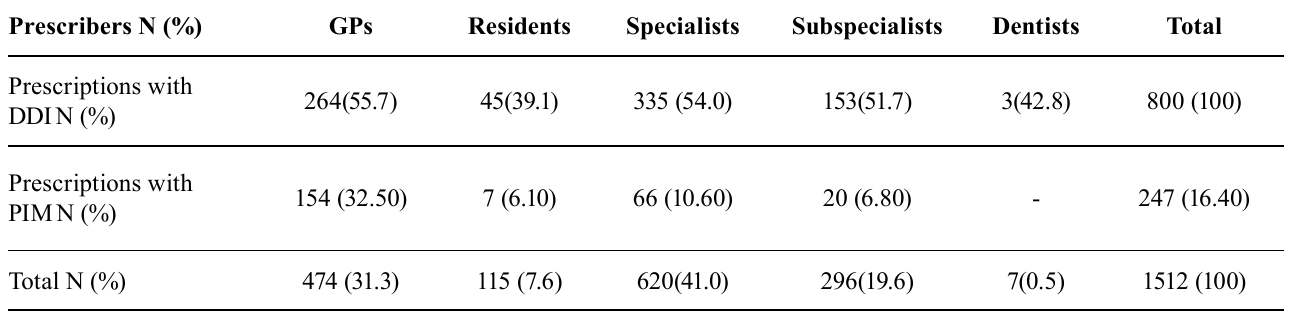
TABLE I – N umber of prescriptions of different prescribers and prevalence of drug interaction and potentially inappropriate